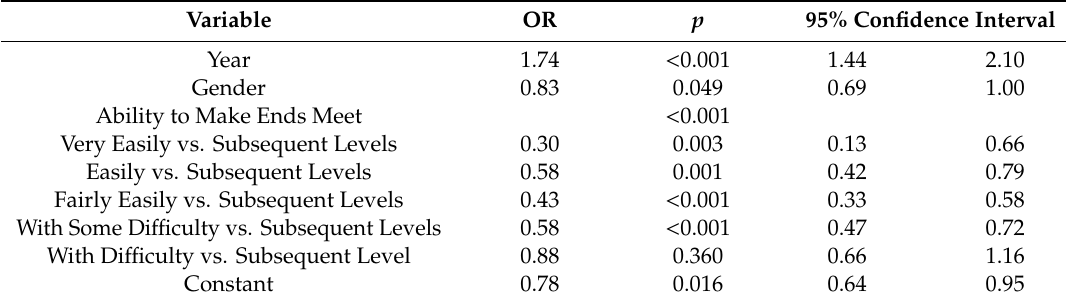
Table 11. Third model (logistic regression model).